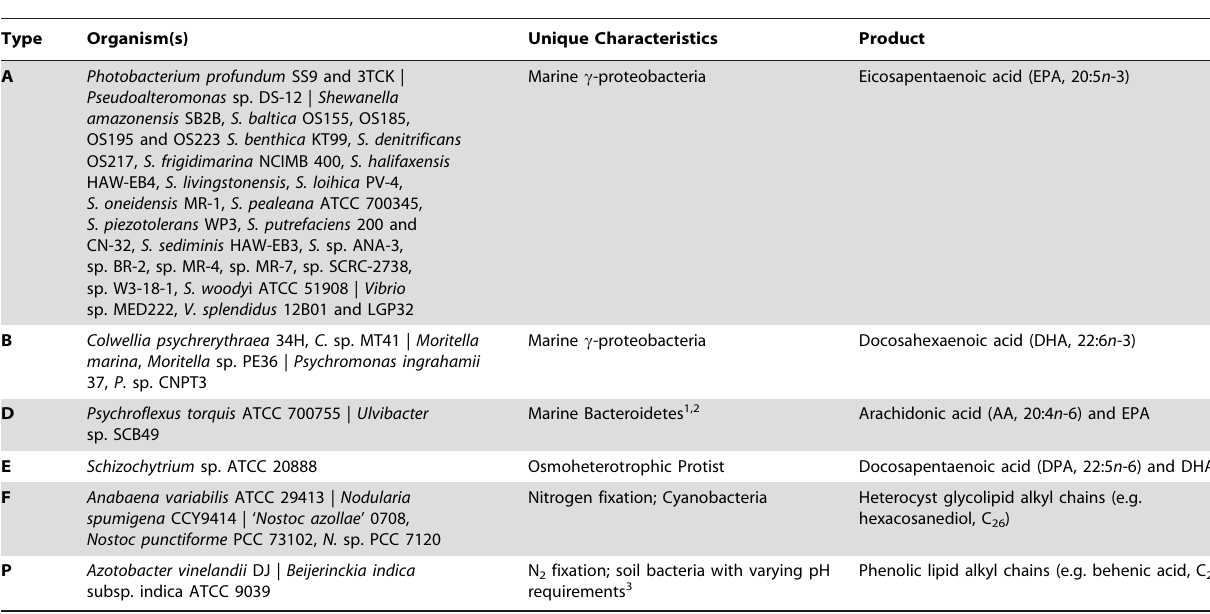
Table 1. Membership and description of secondary lipid synthase types with characterized